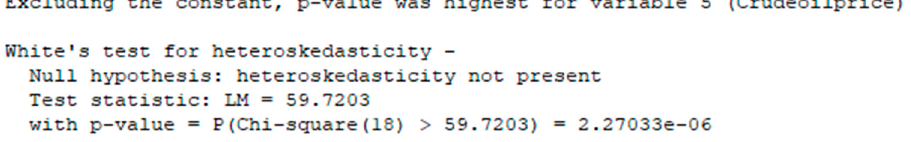
Figure 9. Output statistics for Pooled regression model in period 2014–2020.